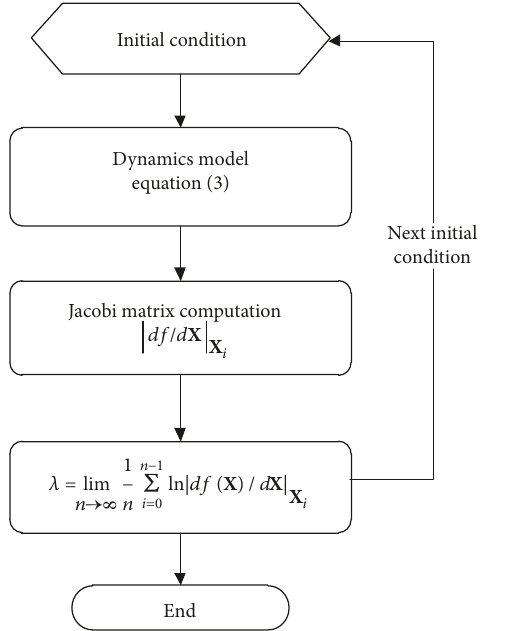
Figure 2: Calculation process of the Lyapunov exponent.